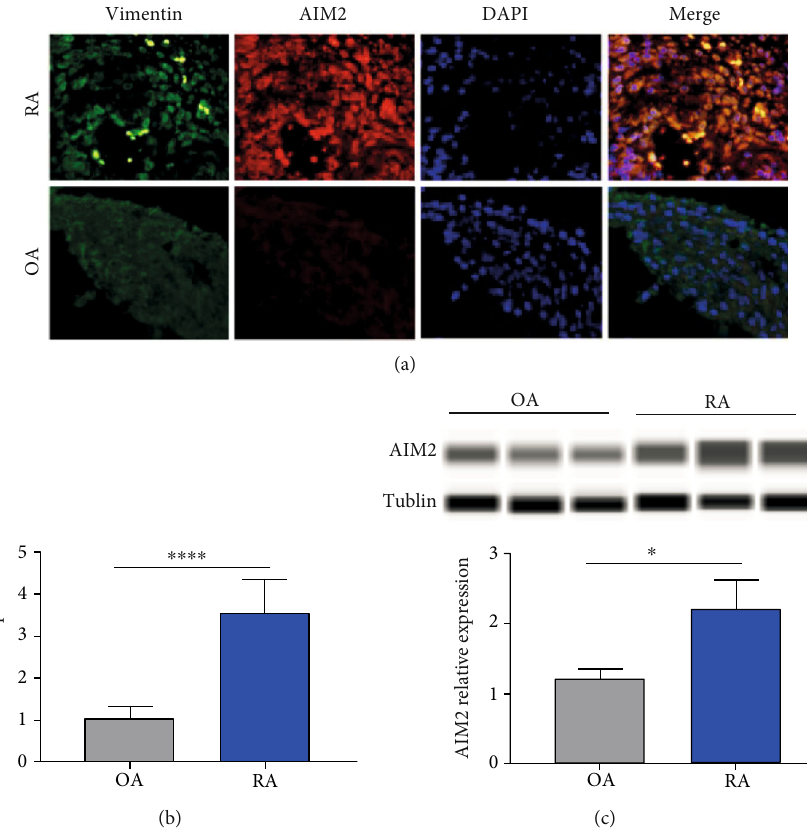
Figure 4: AIM2 is expressed more in RA-FLS than in OA. AIM2 expressed in the cytoplasm of FLS, which is higher in RA-FLS than in OA- FLS ((a) vimentin was labelled as green, AIM2 as red, and nuclei as blue by immuno fl uorescent staining). The relative expression of AIM2 in mRNA and protein levels was higher in RA-FLS than in OA (b, c). ∗ p < 0 : 05 and ∗∗∗∗ p < 0 : 0001